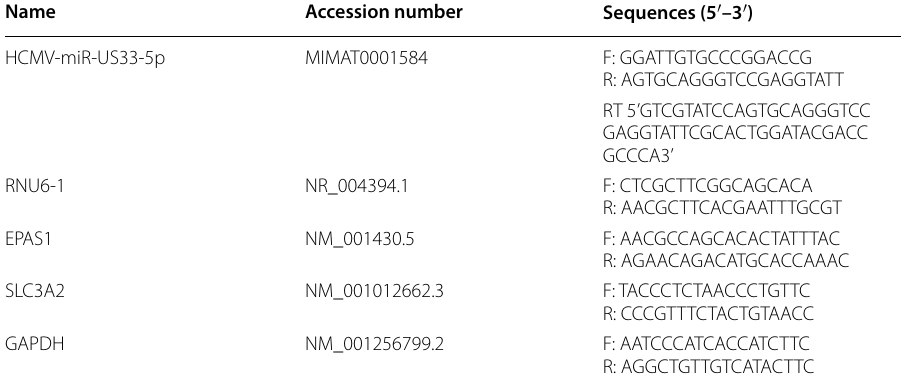
Table 2 Primer sequences Name Accession